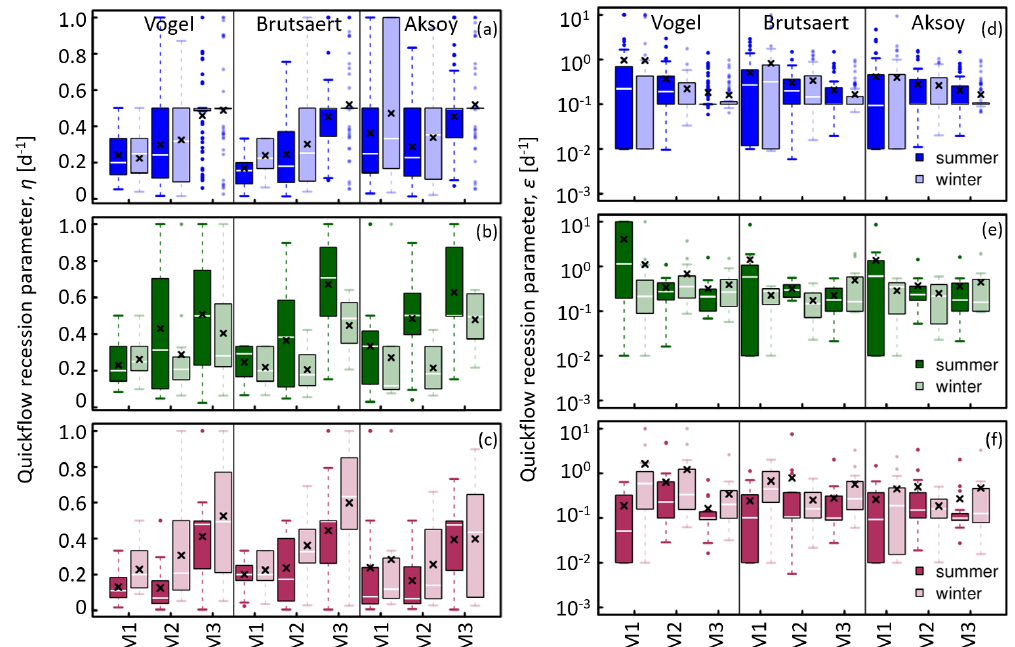
Figure 5. Distribution and variability of the quick-flow recession parameters, η and ε ( y axis of ε in log scale), obtained by the combination of REM (Vogel, Brutsaert, and Aksoy) and POA (M1, M2, and M3) for summer and winter periods: (a, d) Lehnbachquellen spring in the snow-dominated catchment, (b, e) Saivu spring located in the humid catchment, and (c, f) Qachquoch spring in the Mediterranean catchment. The boxplots represent the interquartile range, whisker lines correspond to the most extreme parameter values, and outliers are marked as circles with corresponding box